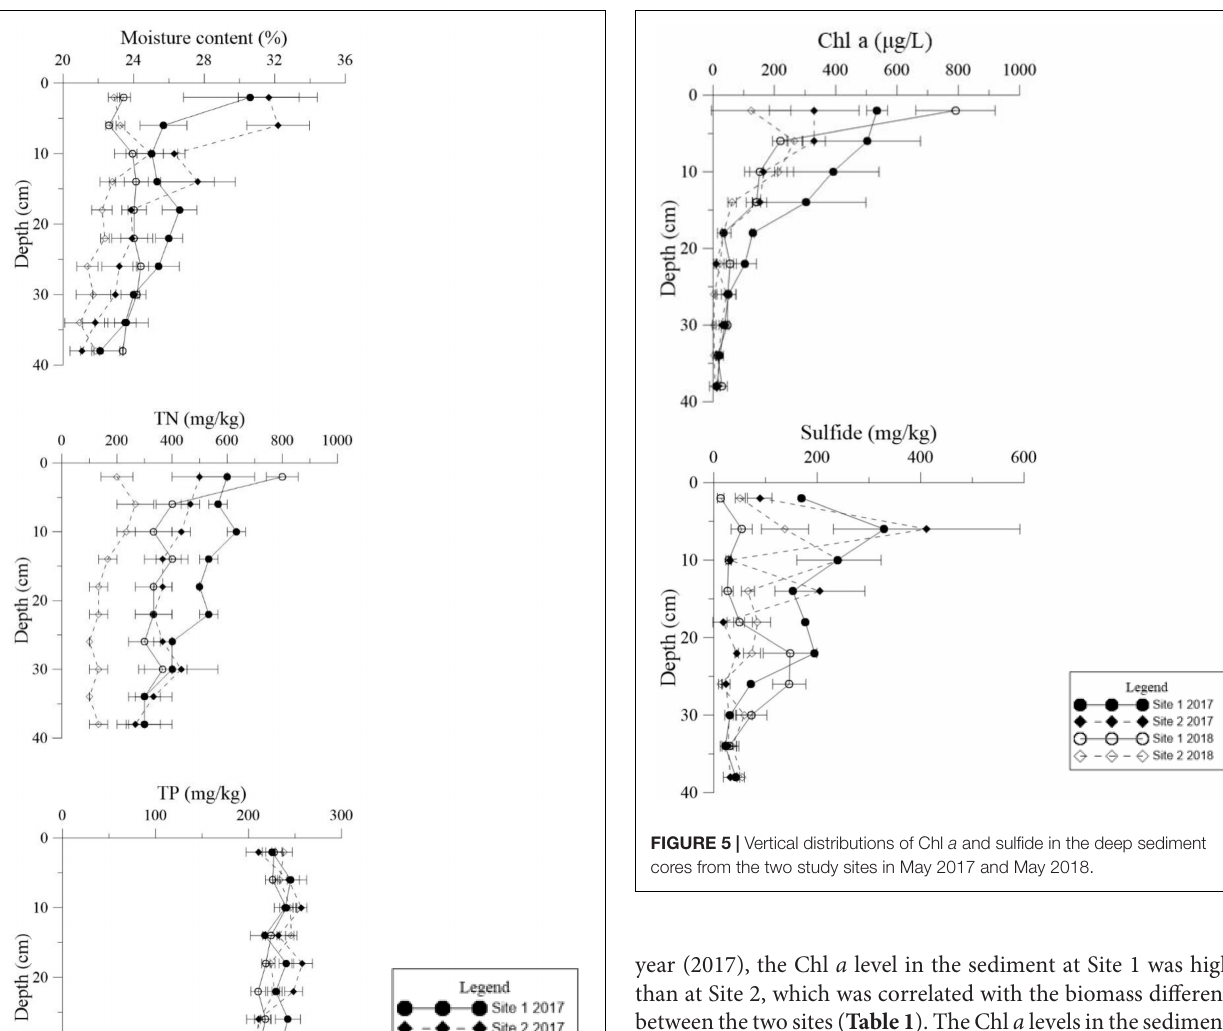
year (2017), the Chl a level in the sediment at Site 1 was higher than at Site 2, which was correlated with the biomass differences between the two sites ( Table 1 ). The Chl a levels in the sediment